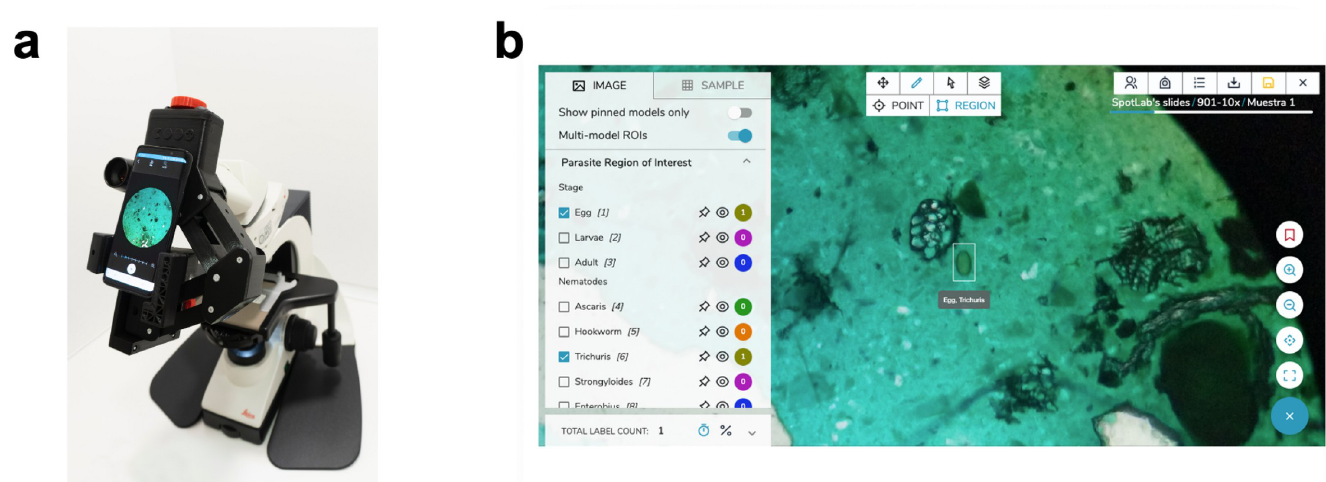
Fig 2. (A) 3D-printed adapter used for attaching a smartphone to a conventional microscope and digitizing samples through a mobile app. (B) Telemedicine web platform for viewing and remote analysis of the digitized samples performing a manual annotation. Note: The web platform in Fig 2B has been developed by the